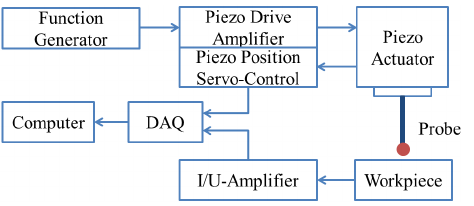
Figure 12. Block diagram indicating key components of the mea- surement